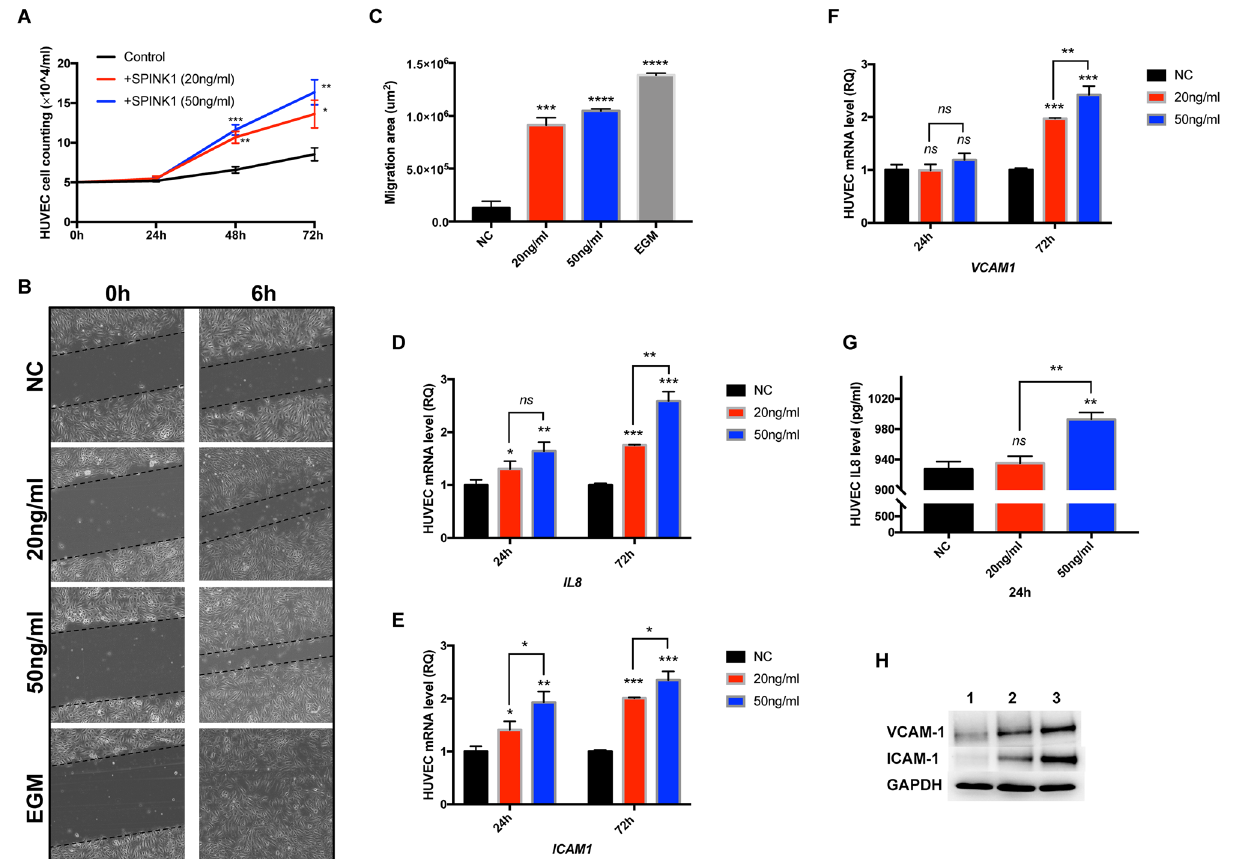
Figure 1. SPINK1 promotes endothelial cell proliferation and migration, and modulates IL-8, VCAM1, ICAM1 expressions in HUVECs. ( A ) Proliferation curve of endothelial cells generated upon various SPINK1 treatments (20 ng/ml or 50 ng/ml) in 72 h. Low-serum media was used as a negative control. ( B ) Endothelial cell monolayer with inflicted wound incubated with low serum medium (negative control), dose-dependent SPINK1 (20, 50 ng/ ml), and endothelial growth medium (EGM, positive control) for 6 h. ( C ) Gap between wound edges assessed upon various SPINK1 treatments. ( D – F ) Various SPINK1 addition caused mRNA increase (IL-8, ICAM1 and VCAM1, respectively) in the endothelial cell monolayer. Low-serum media: negative control. ( G ) Measurement of IL-8 protein levels in HUVEC-CM were raised by SPINK1. ( H ) Immunoprecipitation and Western blot assay with anti-VCAM1 and anti-ICAM1 antibodies; HUVECs were cultured for 3 h with serum-free media followed by 72 h of incubation with 50 ng/ml SPINK1 (lane 2) or with low serum medium as negative control (lane 1) or with 10 ng/ml TNFα for 6 h as positive control (lane 3), stimulated ICAM1 and VCAM-1 protein expressions. The original images of all blots with three replicates are presented in Supplementary Fig. 10. Due to the blots were cut prior to hybridization with antibodies, the images of full-length blots were absent. * p ≤ 0.05, ** p ≤ 0.01, *** p ≤ 0.001, **** p ≤ 0.0001; unpaired